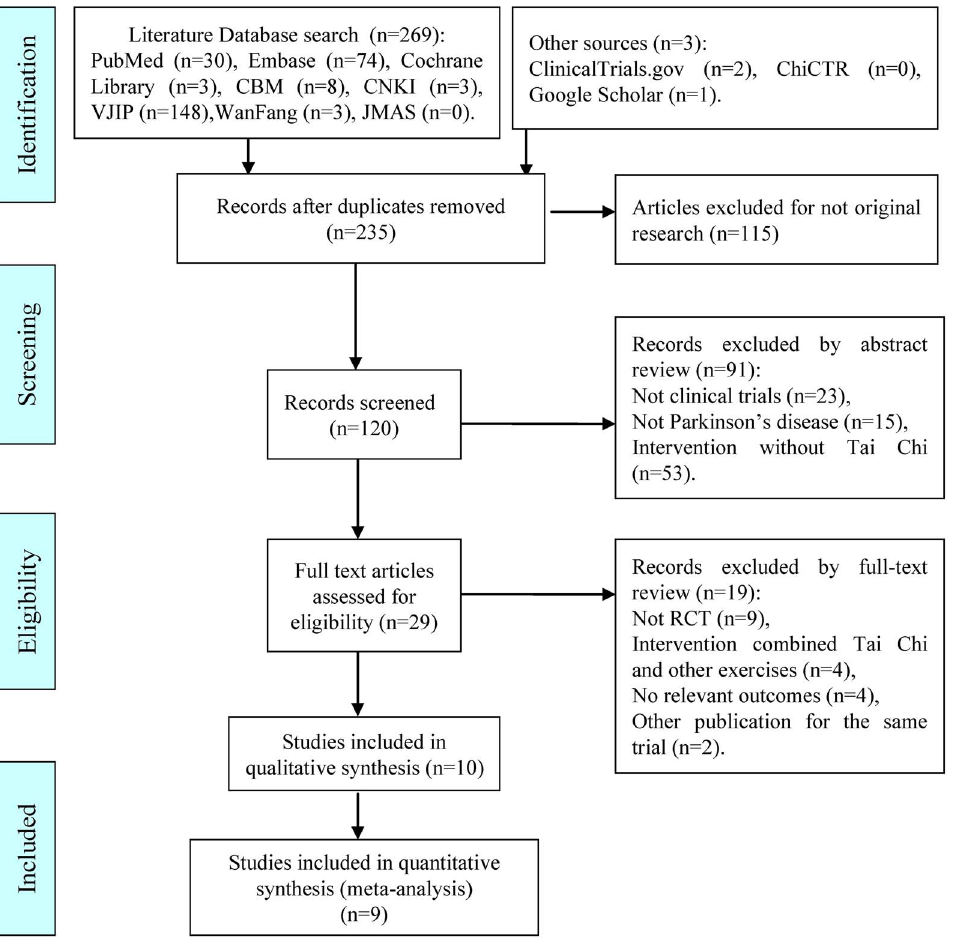
Figure 1. Flow diagram of study selection and identification. The total number of articles and studies differs because one article reported two independent trials and two articles reported different outcomes for the same trial.